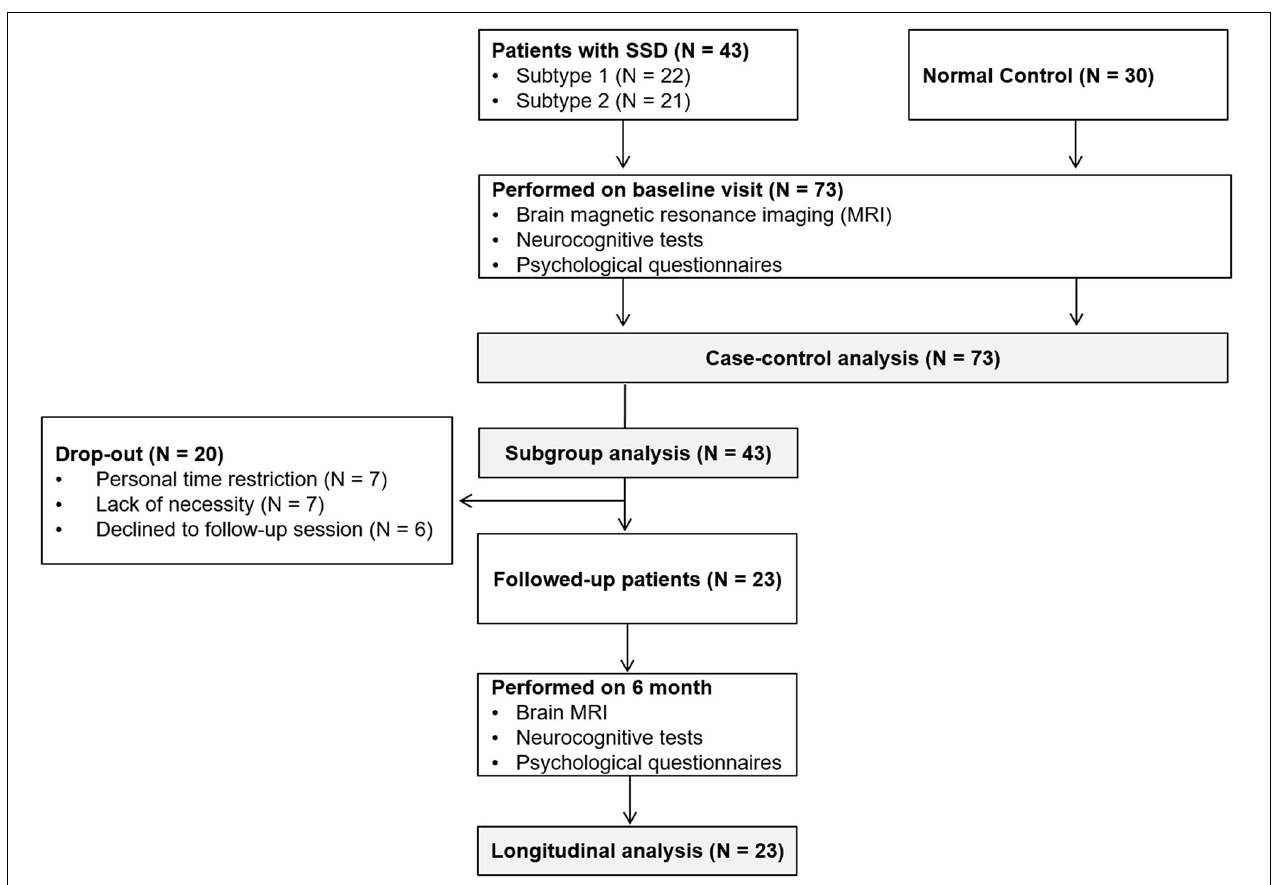
FIGURE 1 | The flow chart of study